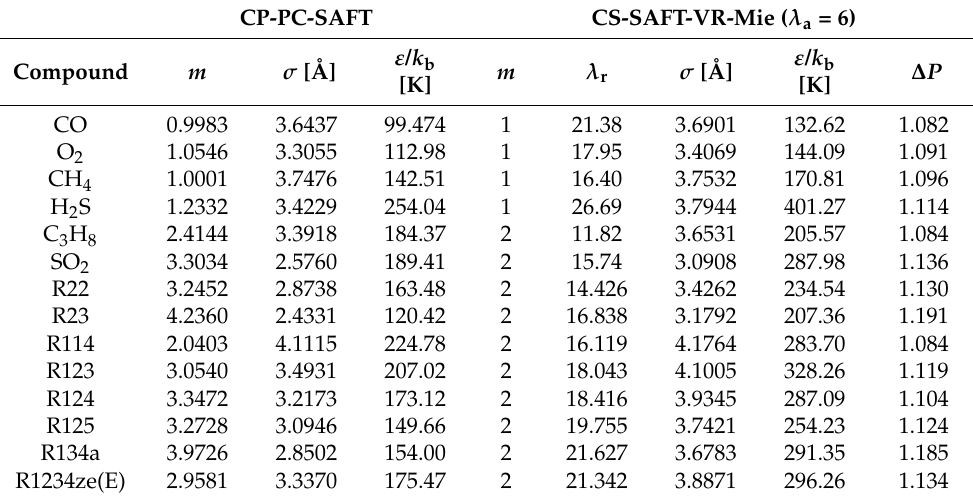
Table 1. Pure compound molecular parameters of CP-PC-SAFT and CS-SAFT-VR-Mie and overesti- mation of P c by CS-SAFT-VR-Mie ( ∆ P ). CP-PC-SAFT CS-SAFT-VR-Mie ( λ a = 6) Compound